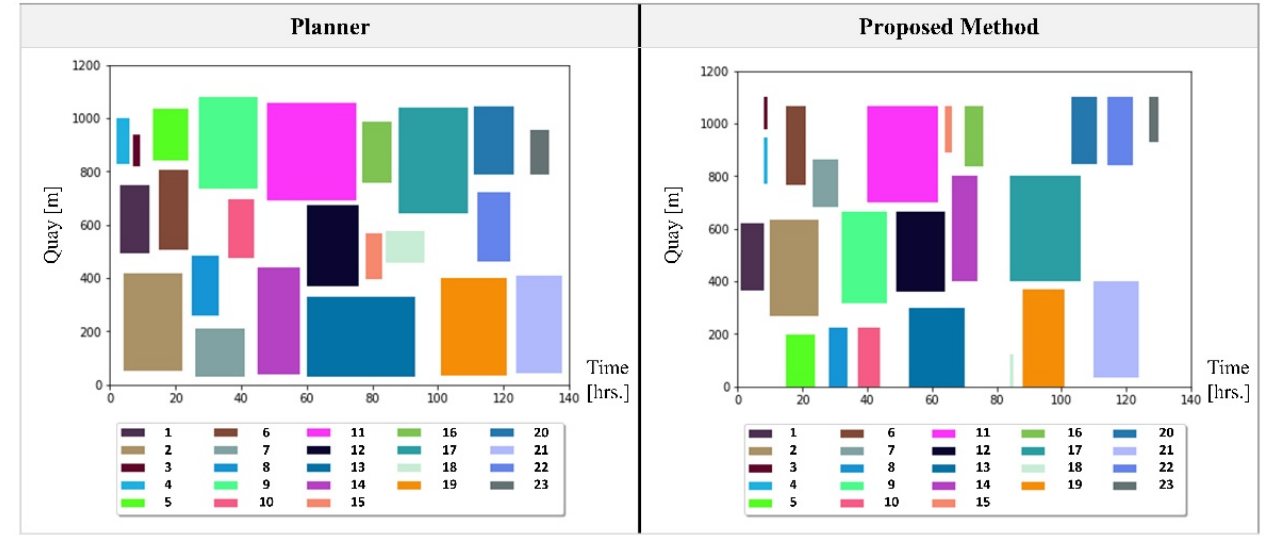
Figure 5. The result of Scenario 1.